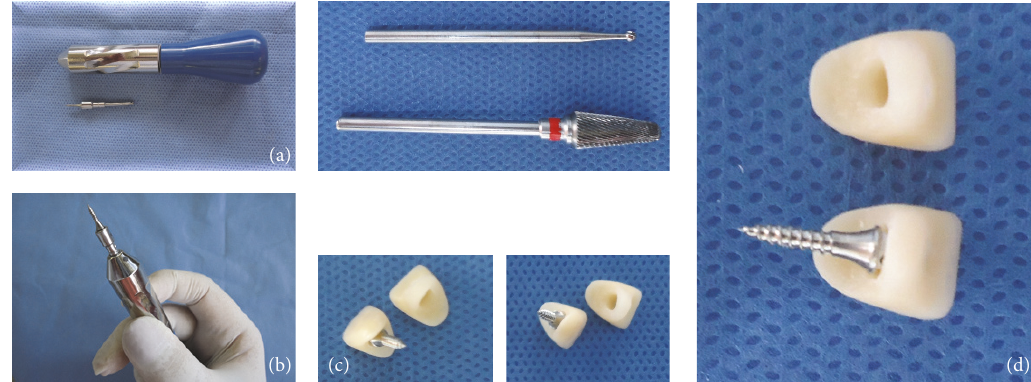
Figure 2: Manual instrument (Morelli, Sorocaba, S˜ao Paulo, Brazil) ((a) and (b)); anatomical conformation of temporary crowns (c); coupling test of the mini-implant and cavity created in the crown